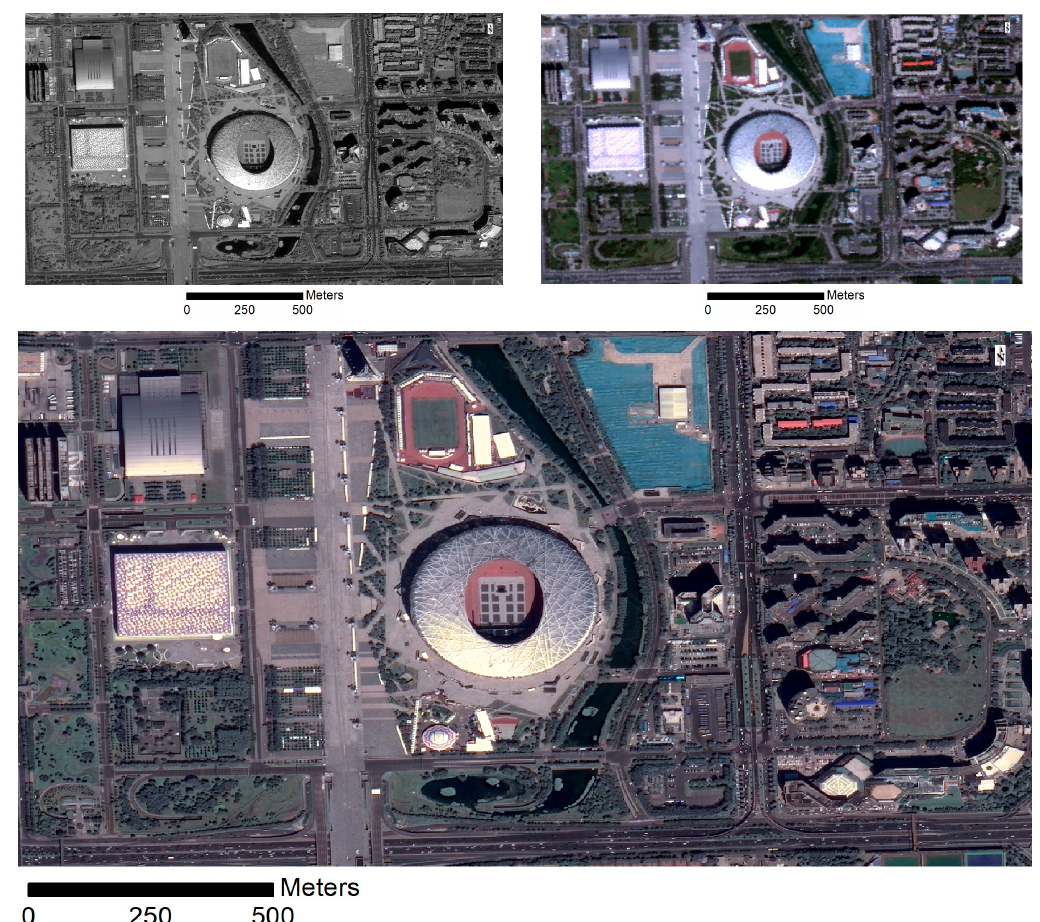
Figure 1. Sample images captured by GF2 PMS sensors at 27 August 2016: the three images cover the same area around the National Stadium at Beijing, where the upper left is a panchromatic image with resolution of 1.0 m, the upper right is the true color composite of a multi-spectral image with resolution of 4.0 m, and the bottom one is the pan-sharped image of the panchromatic and multi-spectral images.